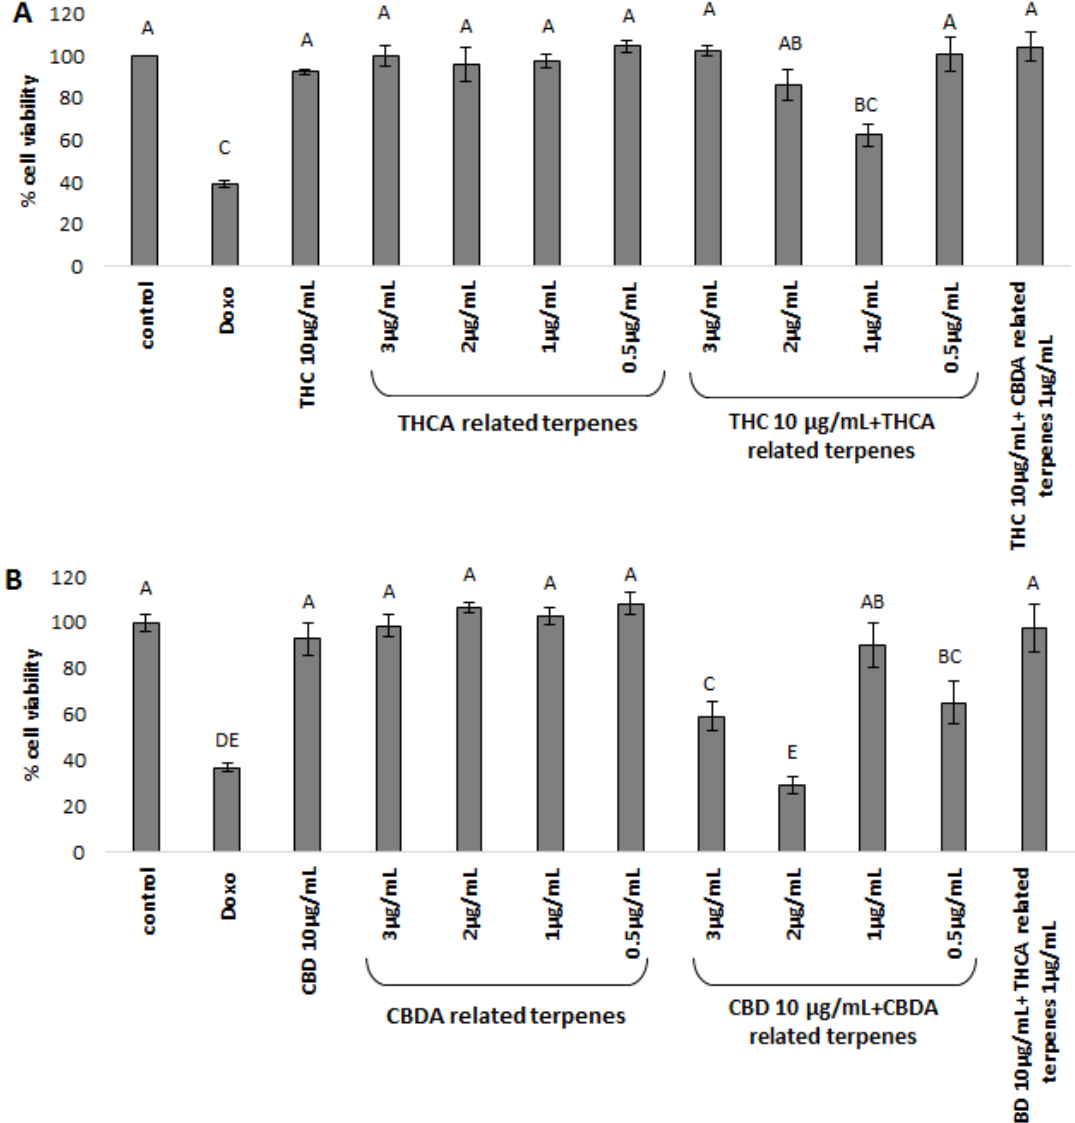
Figure 2. XTT cell viability assay of MDA-MB-231 cell line, treated for 48 h with ( A ) THC and terpene fraction; ( B ) CBD and terpene fraction. THC / CBD—in all treatments the phytocannabinoid concentration was 10 µ g / mL. The various concentrations of co-related terpenes and cross-related terpenes are detailed in the figure. Control—mixture of methanol and hexane (1:1), the solvent used for extraction and treatment. Doxo—doxorubicin 1 µ g / µ L. THCA-related terpenes—terpenes listed in Table 1A for Cs12 strain, fraction 6. CBDA-related terpenes—terpenes listed in Table 1B for the Arbel strain,